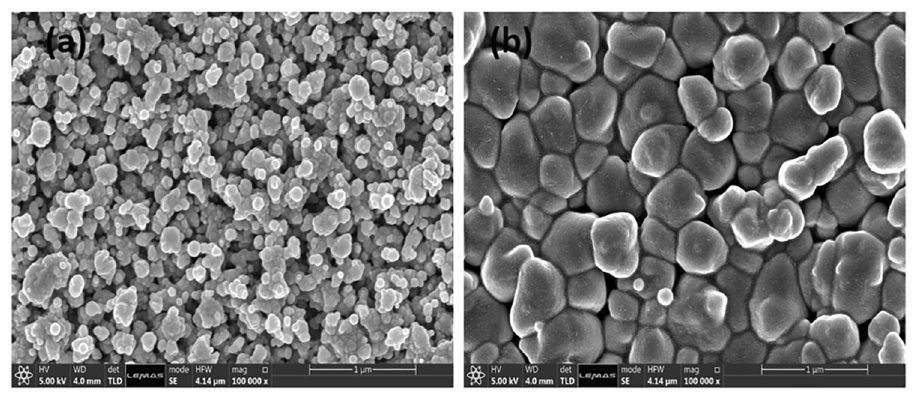
Figure 1. Top-view SEM images of the VO 2 thin film deposited: VT400 [( a )], and VT700 [( b